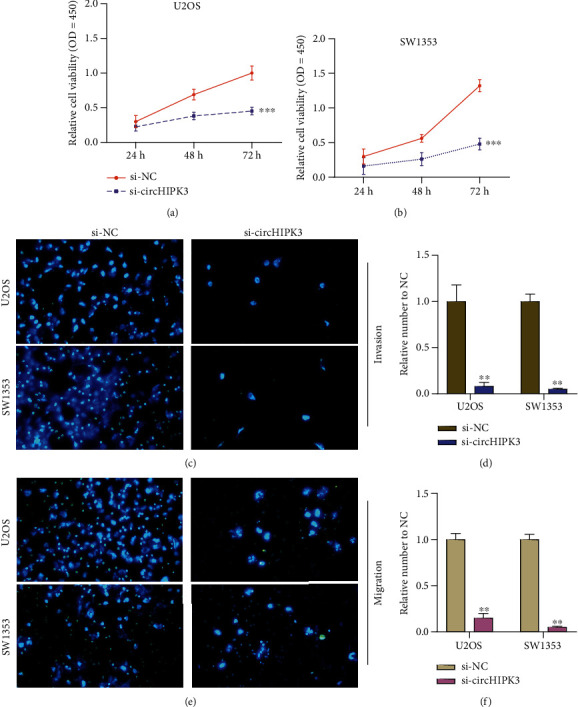
Knockdown of circHIPK3 decreased OS cell proliferation, invasion, and migration. (a, b) The cell proliferation of U2OS and SW1353 cells transfected with si-circHIPK3 was evaluated by CCK-8. (c–f) Invasion and migration numbers in transfected U2OS and SW1353 cells were evaluated by Transwell assays. ∗p < 0.05, ∗∗p < 0.01, and ∗∗∗p < 0.001.